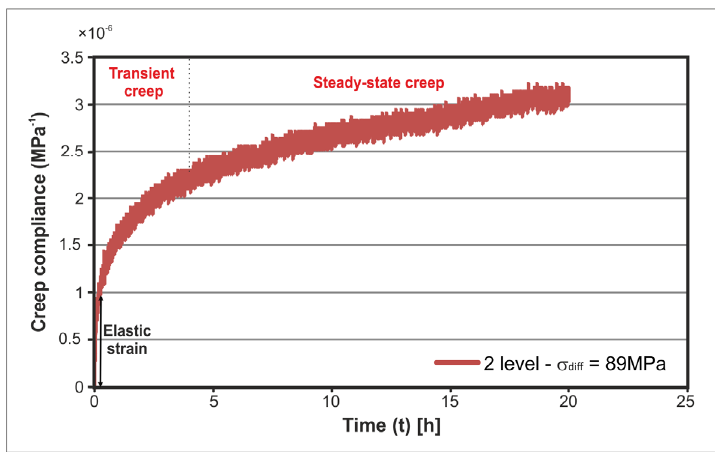
Figure 14. Viscoelastic creep compliance (sample